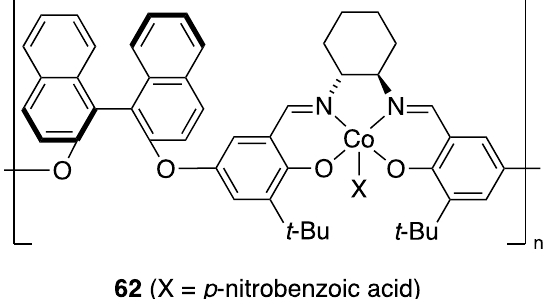
Figure 25. Polymeric Co–salen complex 62 .